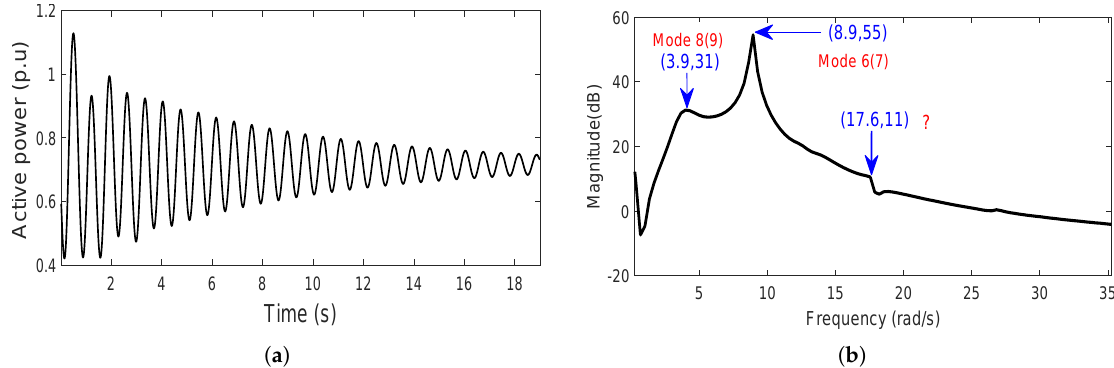
Figure 3. ( a ) Machine 1 active power response for case 1. ( b ) Fast fourier transform (FFT) spectrum of machine 1 active power for case 1 showing less severe nonlinear effects.